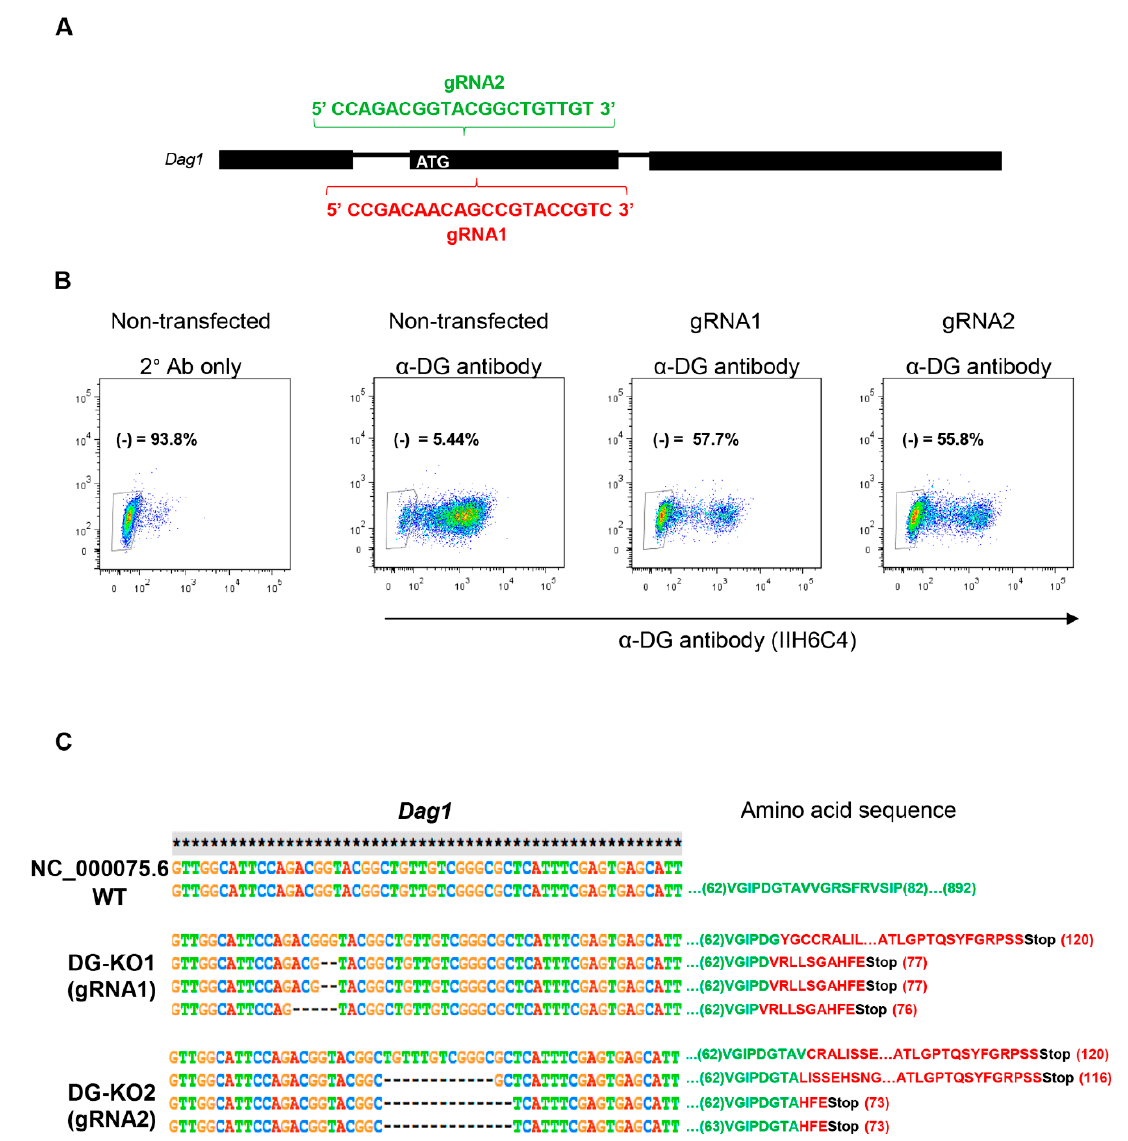
Figure 1. CRISPR / Cas9-engineered dystroglycan knockout (DG-KO) C2C12 cell clones. ( A ) Scheme showing the sequences of guide RNAs (gRNA1 and gRNA2), designed to target Dag1 gene. ( B ) Fluorescence-activated cell sorting (FACS) analysis on C2C12 cells (Table 1), gRNA2 or none gRNA (non-transfected cells), and stained with α -DG antibody, IIH6C4. The absence of IIH6C4 reactivity confirmed the lack of functionally glycosylated α -DG. Non-transfected cells incubated only with secondary antibody (2 ◦ Ab only) were used to adjust the population negative for α -DG immunostaining ( α -DG (-)). Percentages correspond to α -DG (-) population. ( C ) Sequence alignment of mouse Dag1 gene (annotated) showing the introduction of indels in DG-KO1 and DG-KO2 cell lines compared with WT cells. Amino acid sequence shows the position of the stop codons generated in DG-KO1 and DG-KO2 cell clones.